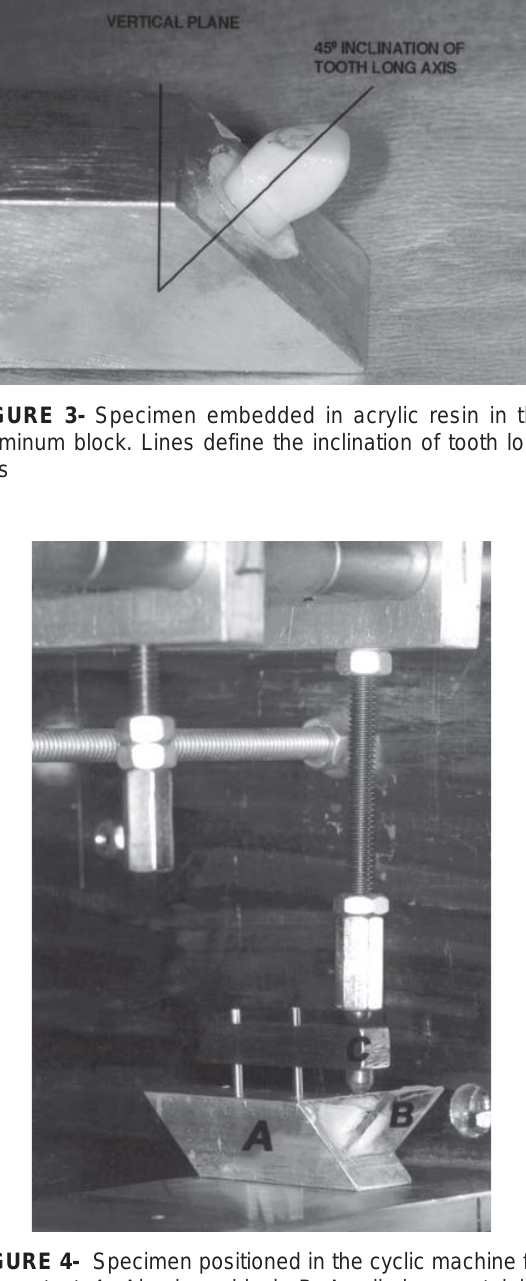
FIGURE 2- Final preparation display with corresponding measures: A - Lingual preparation with 0.8mm width; B- Remaining dentin for the ferrule effect of crowns with 1.5mm height and C- Core with 4.5mm height